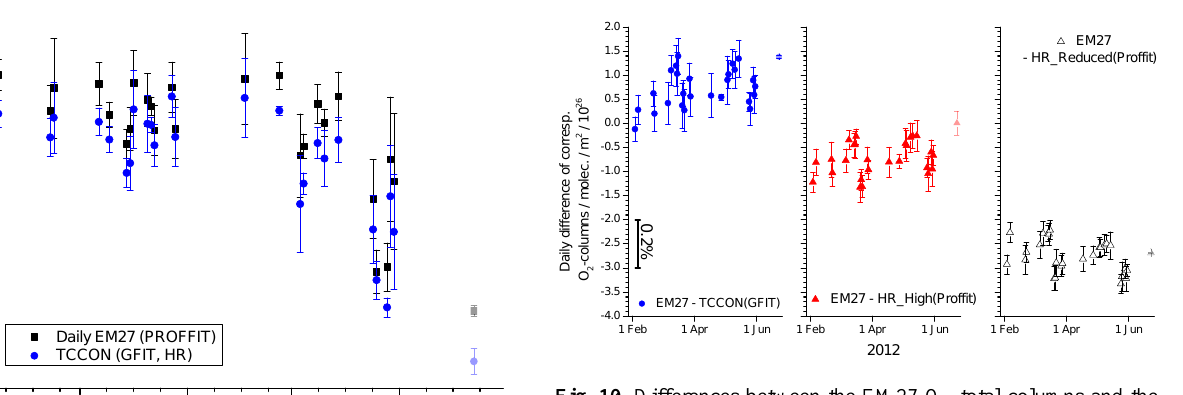
Fig. 10. Differences between the EM27 O 2 total columns and the 3 other datasets, where the daily means of the differences with the according 1- σ error bars are shown. To obtain the differences, only IFGs were taken into account, which were recorded at the same time. The last day is preliminary only and not taken into account in the statistical